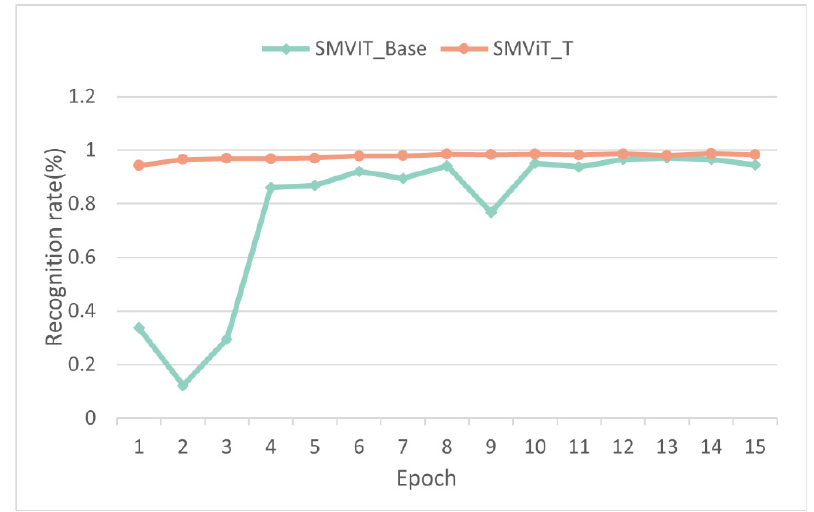
Figure 9. Reliability verification of the gradually moving ‐ view training method at 18°.